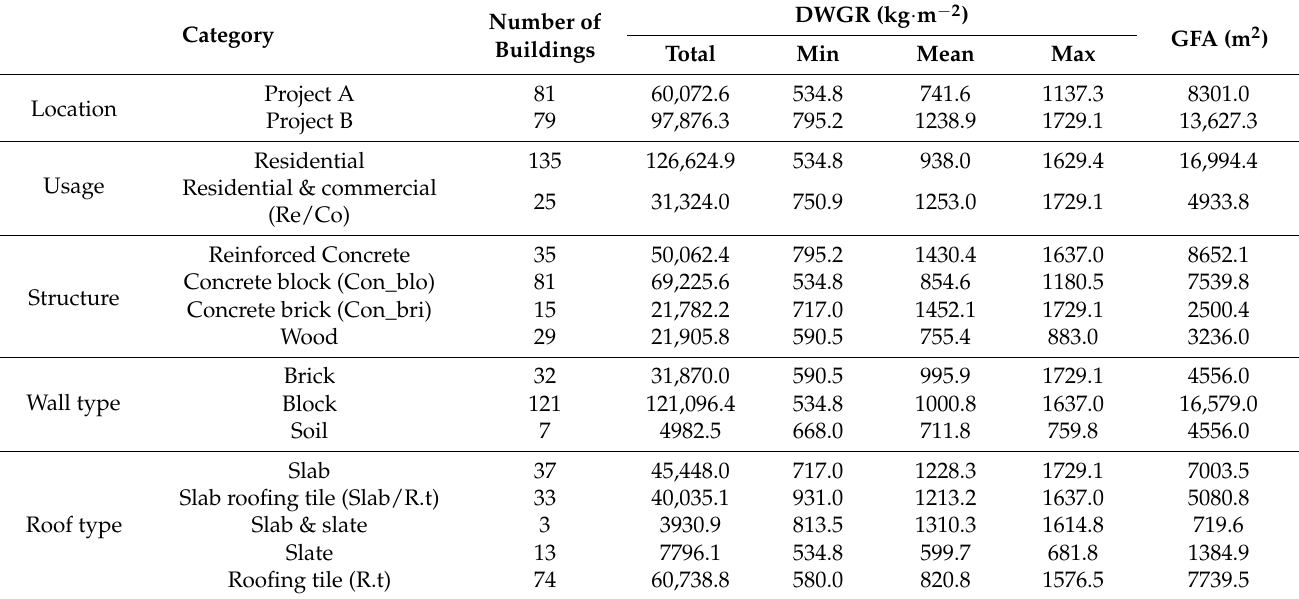
Table 1. Building status and statistical analysis of dataset used in this